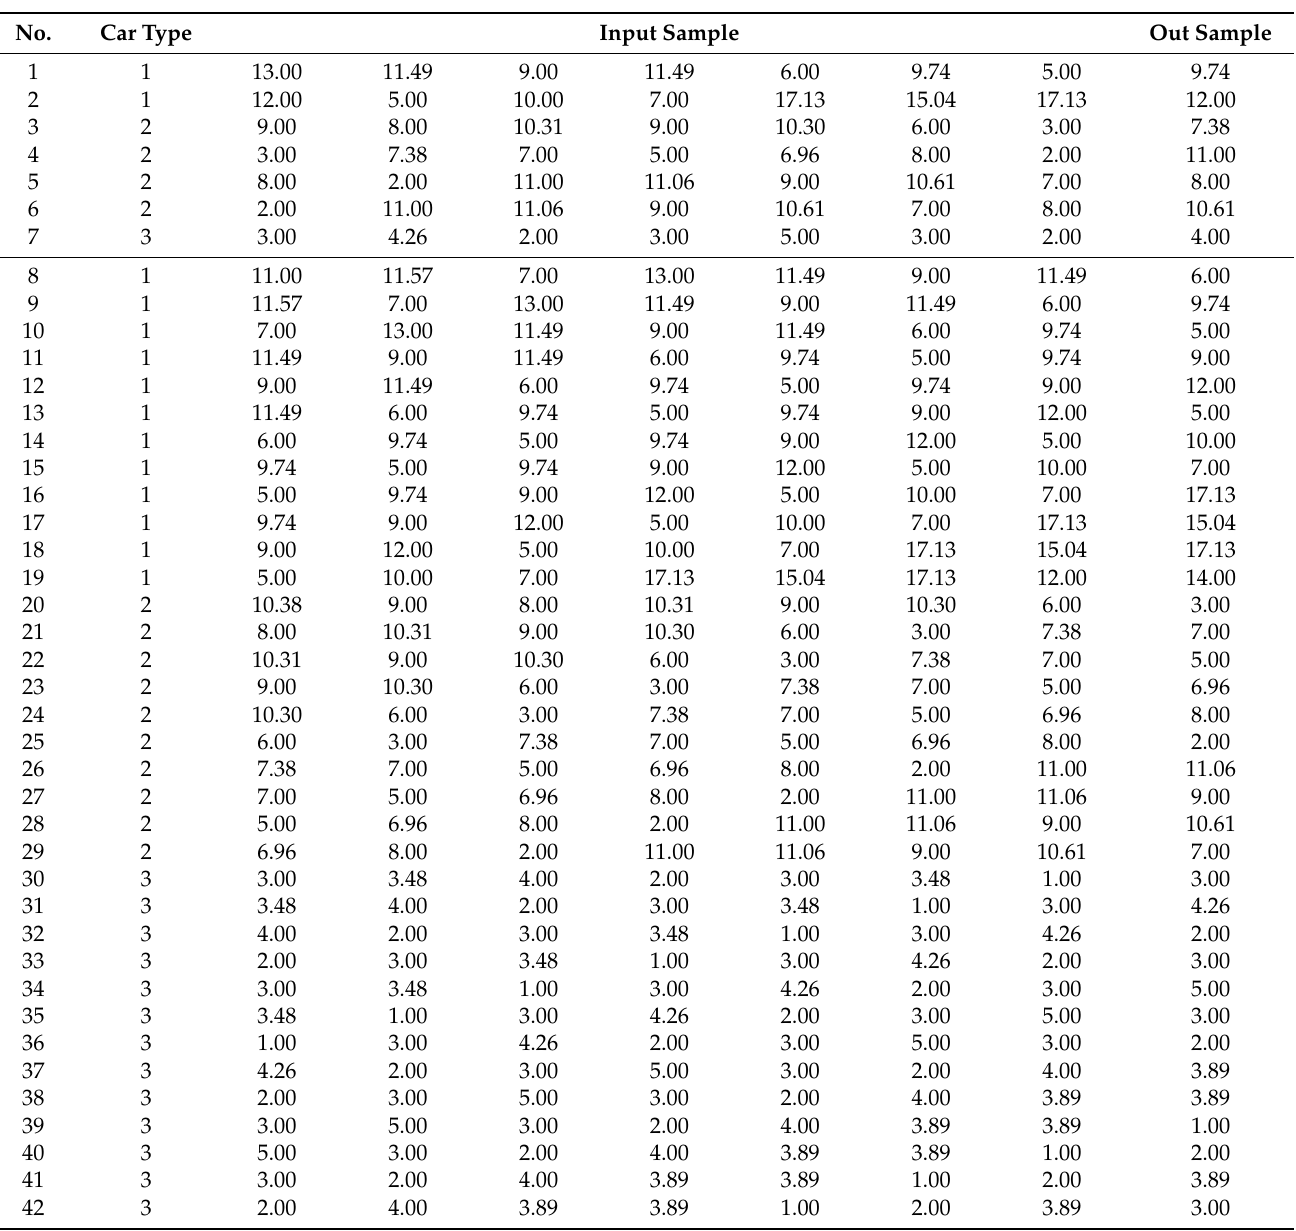
Table 9. Prediction samples and training